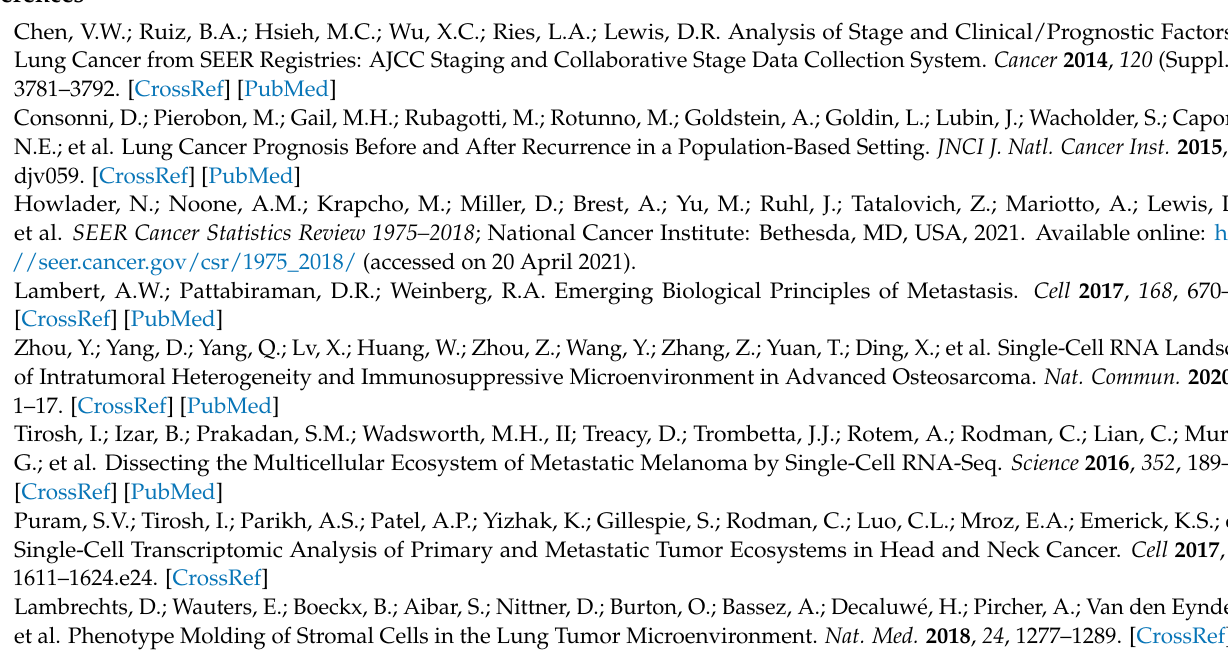
7; Figure S4: Metastasis-related GO analysis and GSEA; Figure S5: Detection of FABP7 on cell proliferation; Figure S6: GO/KEGG analyses and qPCR for lipid-related pathways; Figure S7: GO analysis and GSEA for Wnt signaling pathway; Table S1: metastatic vs. non-metastatic all cell types GO; Table S2: metastatic vs. non-metastatic all cell types KEGG; Table S3: FABP7 positive vs. negative TUMOR GO and